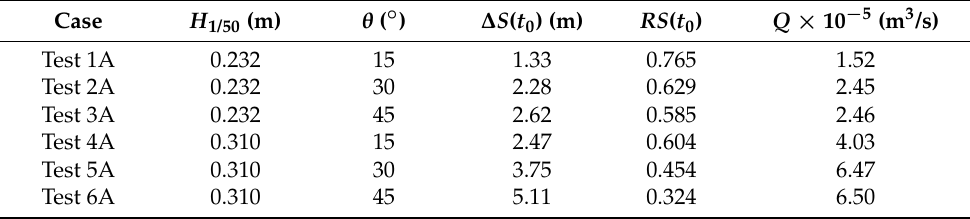
Table 4. GSb simulated cases to investigate beach resistance to a 10 m groin, for waves of T p = 3.5 s, after 720 h ( t 0 ) of simulation.